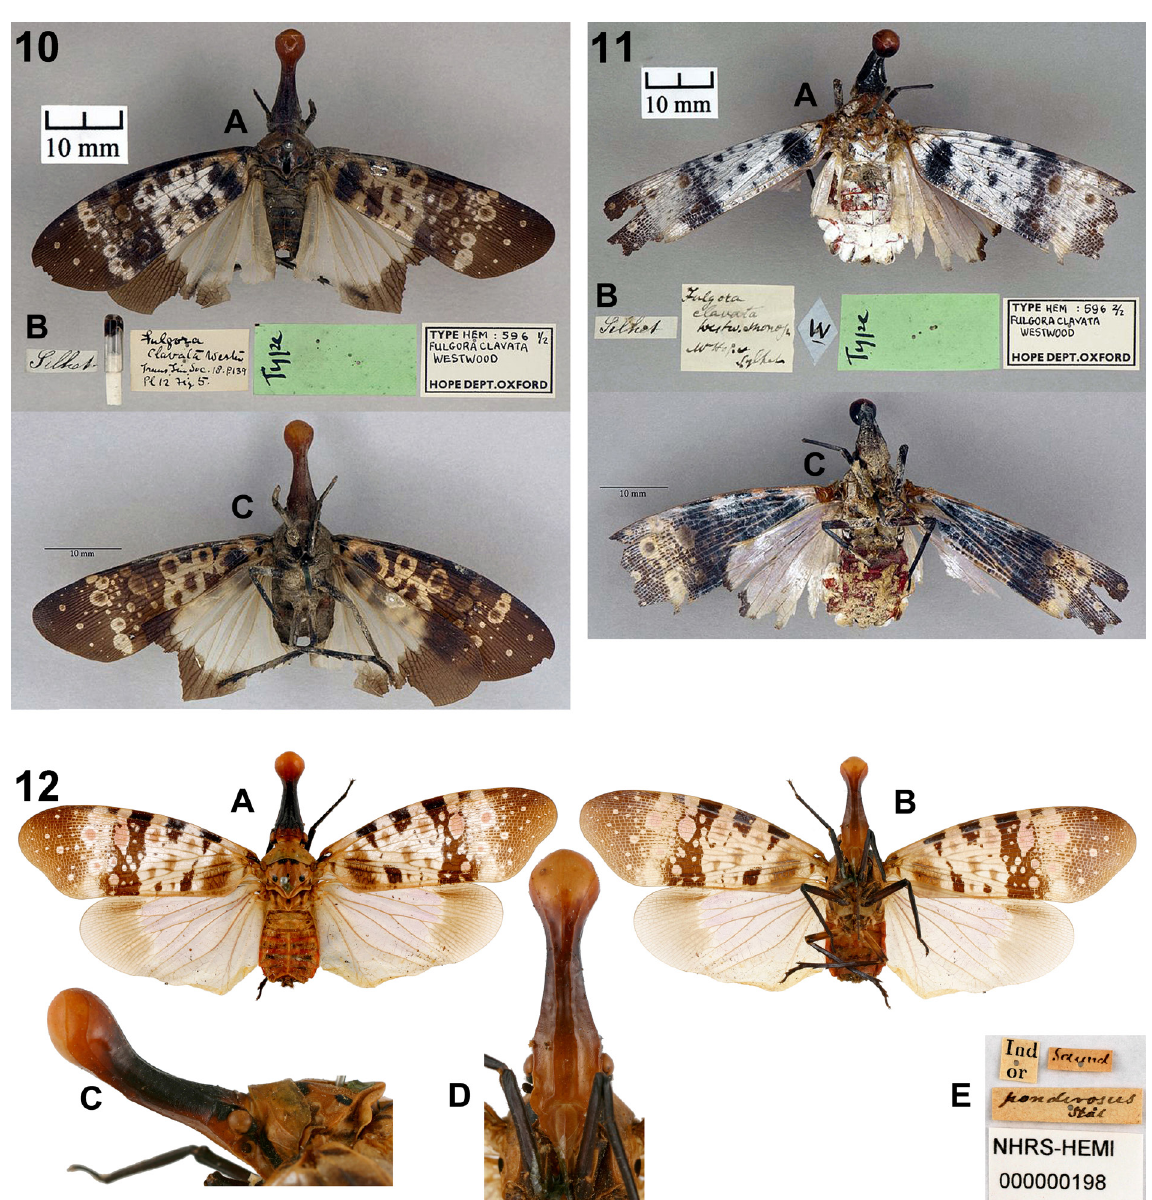
Figs 10–12. Pyrops clavatus (Westwood, 1839) and synonymised species, type specimens. 10 . Fulgora clavata Westwood, 1839, lectotype, ♂ (OUMNH, photographs by A. Spooner). A . Habitus, dorsal view. B . Labels and genitalia tube. C . Habitus, ventral view. — 11 . F. clavata Westwood, 1839, paralectotype, ♀ (OUMNH, photographs by A. Spooner). A . Habitus, dorsal view. B . Labels. C . Habitus, ventral view. — 12 . Hotinus ponderosus Stål, 1854, holotype, ♀ (NHRS, photographs by J. Constant). A . Habitus, dorsal view. B . Habitus, ventral view. C . Head and thorax, left lateral view. D . Head, normal view of frons. E . Labels. Wingspan: 88